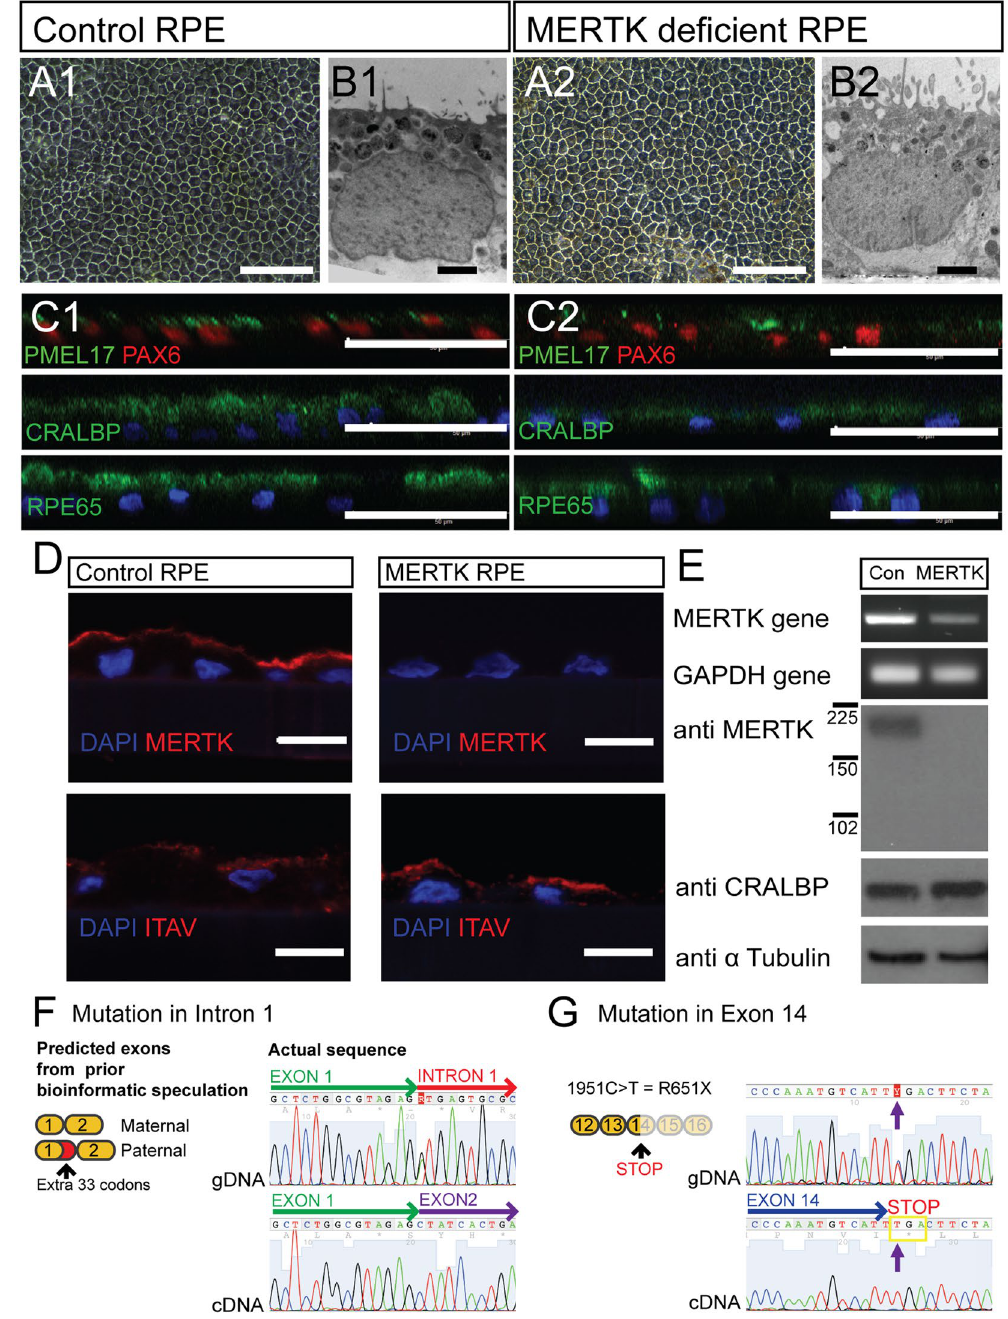
Figure 2. Characterisation of control and MERTK-RPE. ( A1 , 2) Light micrograph of control and MERTK- RPE cells in culture (scale bar 50 μ m). ( B1 , 2) Electron micrograph of control and MERTK-RPE (scale bar 1 μ m). ( C1 , 2) Immunocytochemistry of iPSC derived RPE (scale bar 40 μ m). ( D) Immunohistochemistry of the control RPE and MERTK-RPE (scale bar = 10 μ m). ( E) RT PCR gel electrophoresis and Western blot of the MERTK gene and protein in the control RPE and MERTK-RPE. ( F ) gDNA sequence from MERTK fibroblasts of the exon 1/intron 1 junction of the MERTK gene compared to the corresponding MERTK-RPE derived cDNA sequence at the exon 1/exon 2 border. ( G ) gDNA sequence of MERTK fibroblasts compared to MERTK- RPE cDNA sequence in exon 14 of the MERTK